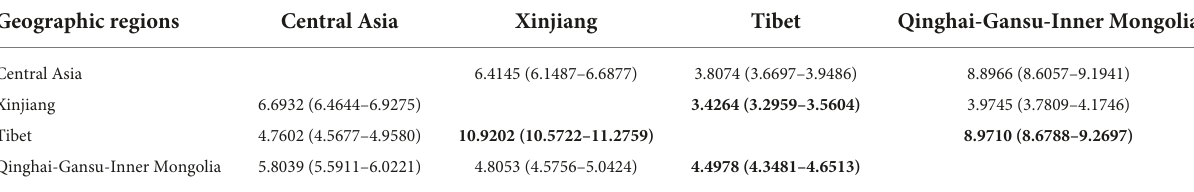
TABLE 4 Estimates of migration rate (M) and 95% confidence intervals (CI) (in parentheses) between four Scrophularia incisa complex geographic regions using MIGRATE. Geographic regions